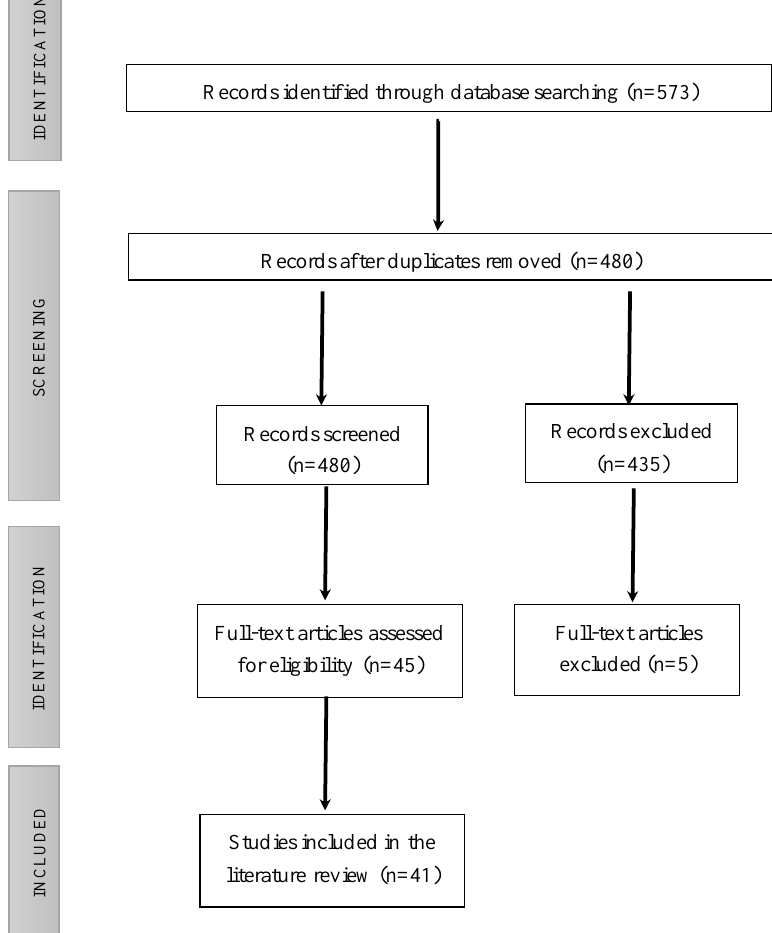
Figure 1. Flow chart showing the methodology and selection processes applied in the present review.